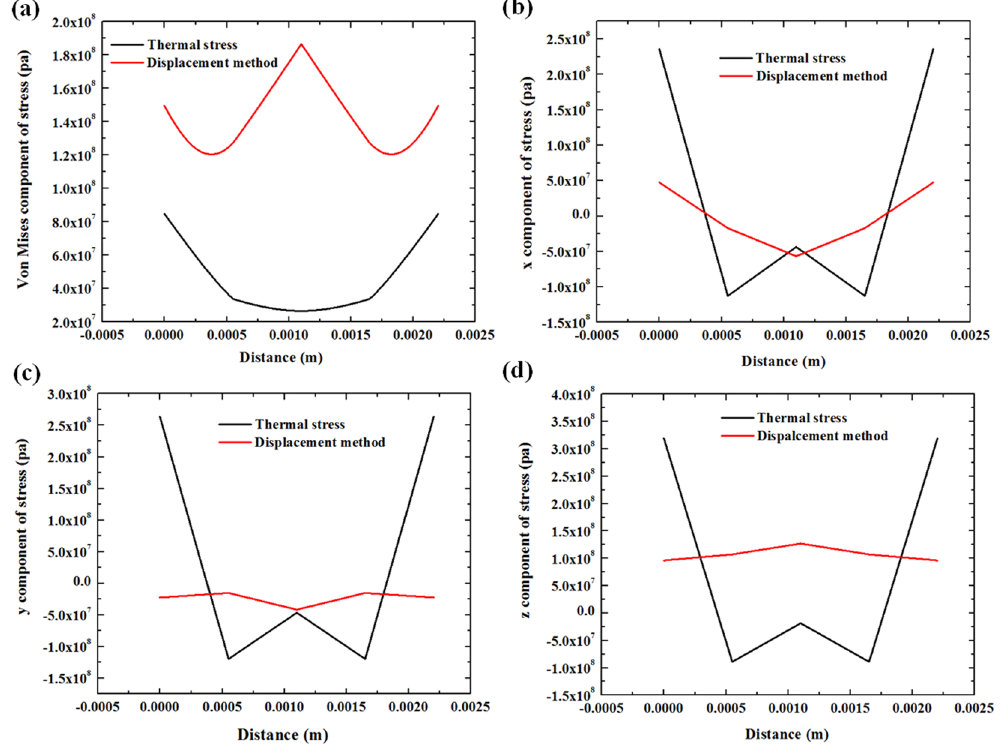
Figure 9. The stress distribution along the surface of the deposition layer in section B. ( a ) von Mises stress, ( b ) x component of stress, ( c ) y component of stress, ( d ) z component of stress.